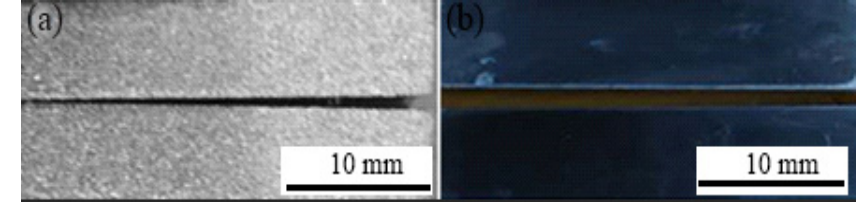
Figure 1. Photos of the prepared specimens: ( a ) grit-blasted samples; ( b ) polished samples.